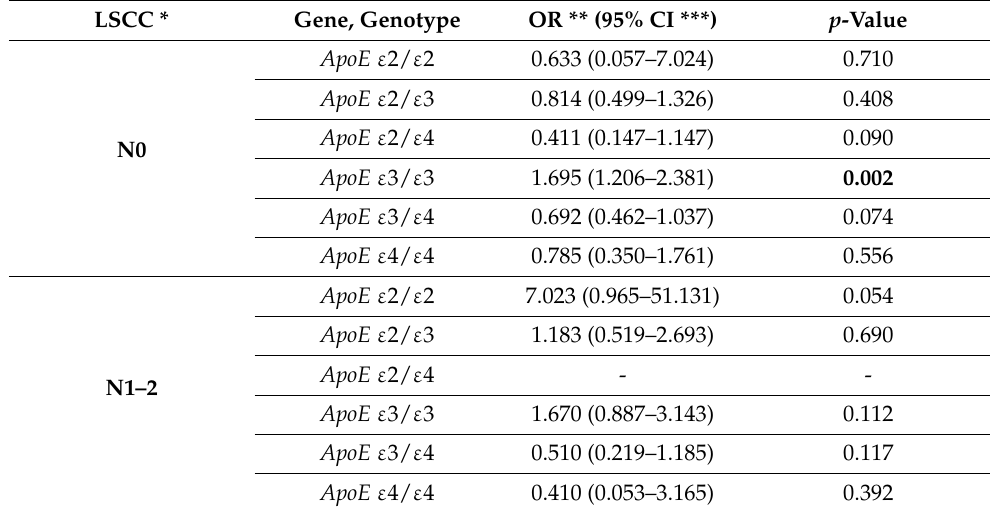
Table 9. Binary logistic regression analysis of ApoE in the control group and LSCC patients with (N1–2) and without (N0) metastases to the lymph nodes. LSCC * Gene, Genotype OR ** (95% CI ***)